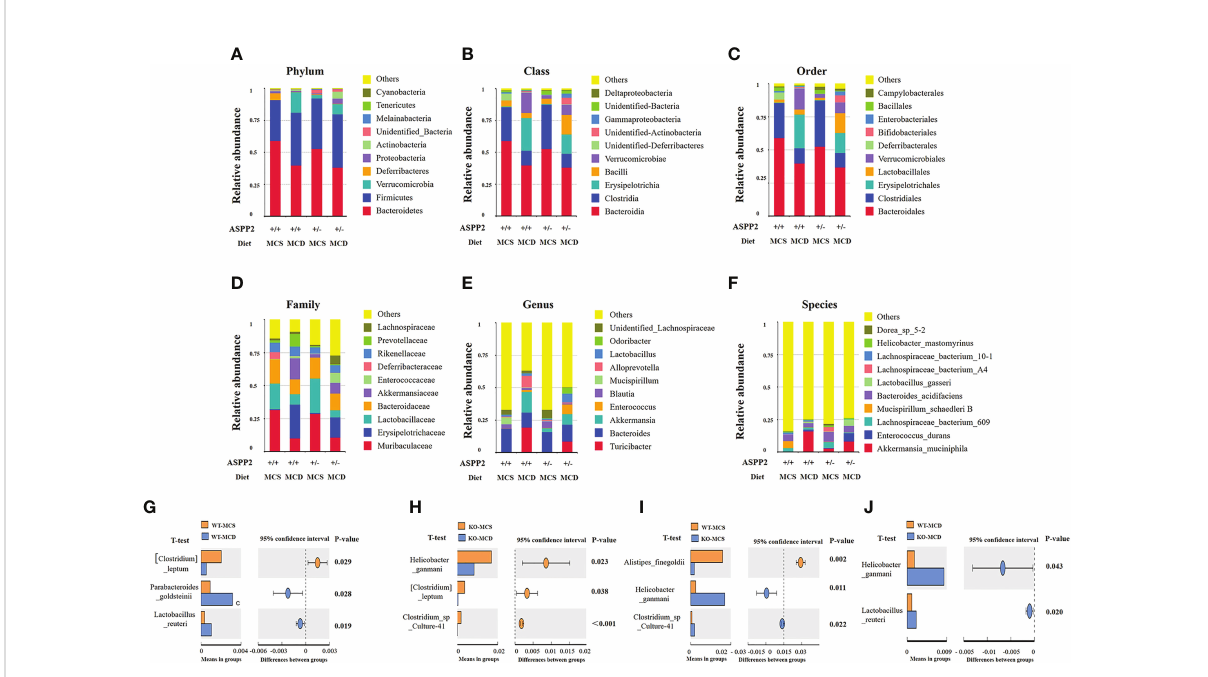
FIGURE 5 Stacked bar plots depicting phylum (A) , class (B) , order (C) , family (D) , genes (E) and Species (F) -level differences in gut microbiota composition between the ASPP2 +/- and WT mice groups with MCS or MCD diet. (G – J) Changes in species richness in ASPP2 +/- and WT groups of mice induced by MCD and MCS diet for 10 days. Different microbiota detected by